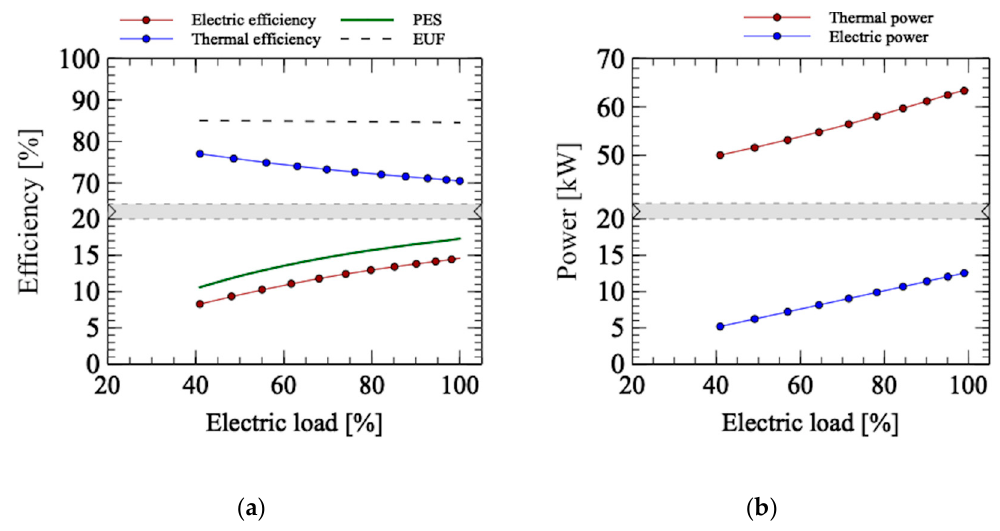
Figure 7. E ff ect of electric load on thermal and electric performance. E ffi ciency ( a ); Power ( b ). Figure 7. Effect of electric load on thermal and electric performance. Efficiency ( a ); Power ( b ).